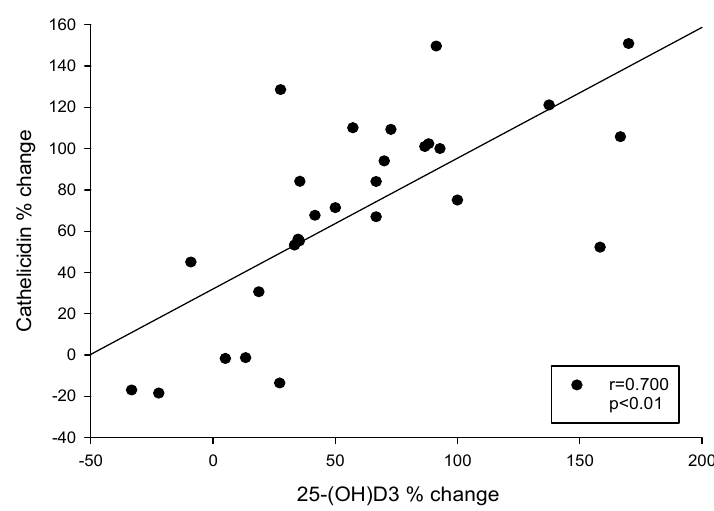
Figure 5. Correlation between percentage change of serum cathelicidin and 25(OH)D 3 between baseline and 16 weeks after initiation of dual vitamin ‐ D (paricalcitol + cholecalciferol) treatment.